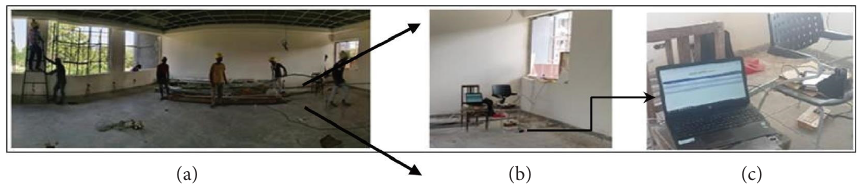
Figure 24: (a) Construction Site with multiple workers wearing tagged helmets. (b) On-site measurement setup. (c) Zoomed view of measurement set up.